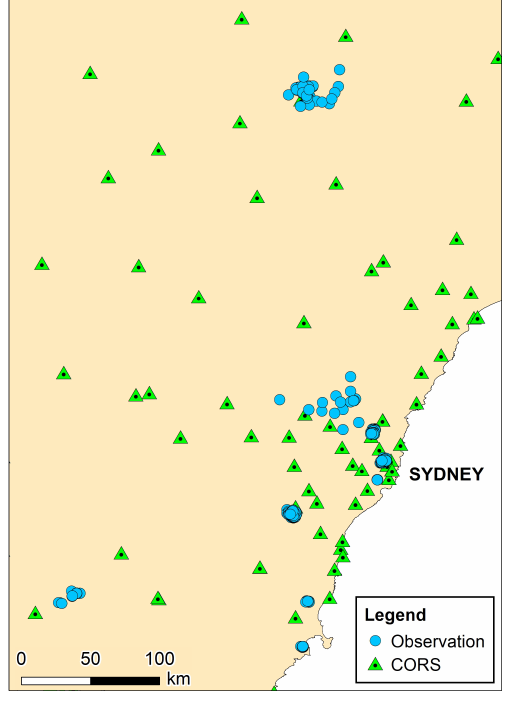
Fig. 1. Location of CORSnet-NSW sites and NRTK data collected across eastern NSW.